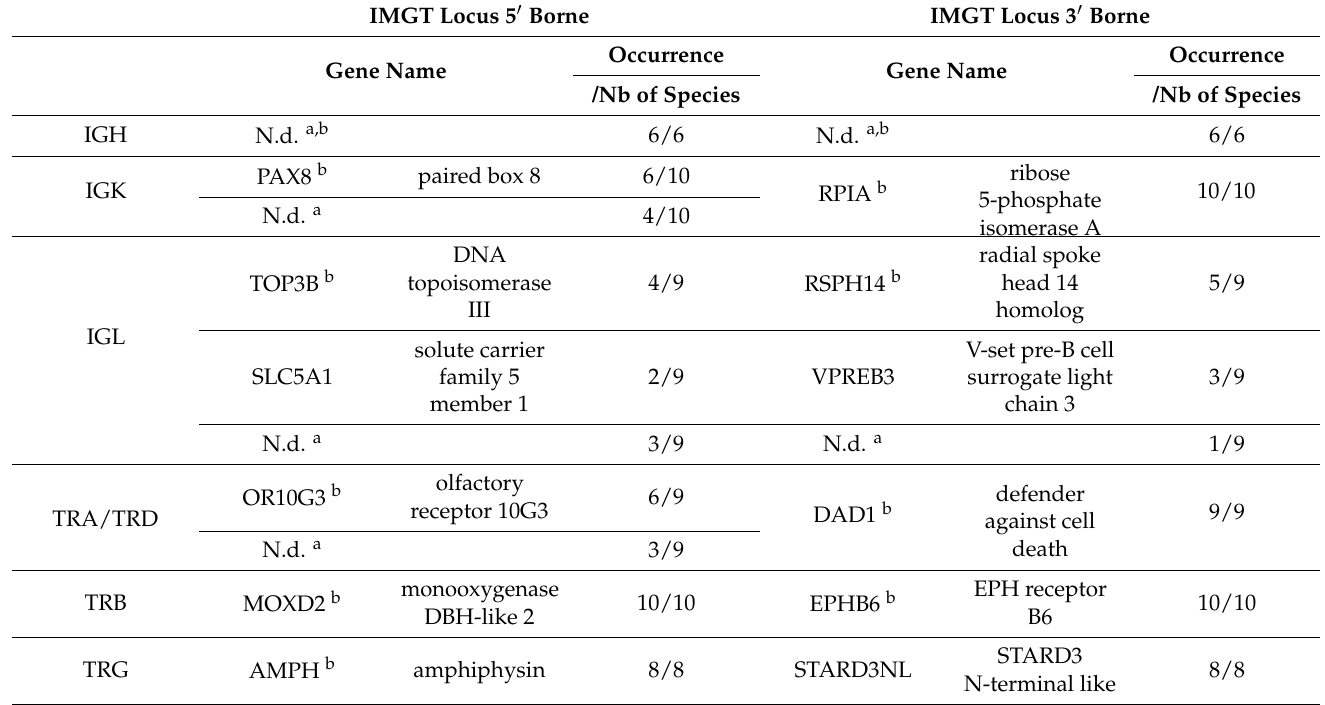
Table 2. IMGT Locus 5 (cid:48) and 3 (cid:48) bornes of the IG and TR loci. IMGT Locus 5 (cid:48)